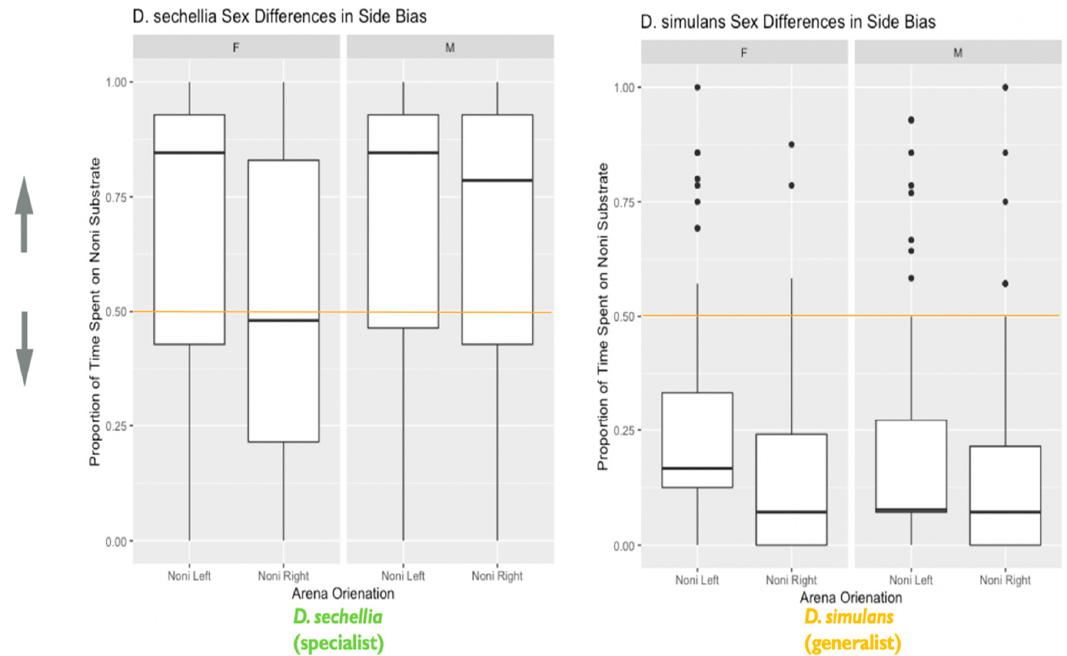
Figure 6. Species and sex di ff erences in the e ff ect of side bias on habitat choice: the plot represents species and sex di ff erences in the e ff ect of side bias on habitat choice, as described in the main text. Data are from the second experiment measuring habitat choice as a representation of decision making. The y-axis represents the proportion of time spent on the imitation noni substrate. Lower values closer to 0 indicate a habitat preference for the plain substrate, while higher values closer to 1 indicate a habitat preference for the imitation noni substrate. A value on or near 0.5 (marked by the orange line) indicates no demonstrable habitat preference for either the plain or imitation noni substrates. The x-axis is divided both by sex, as well as the arena orientation i.e., whether imitation noni substrate was on the left or right ( n = 526 flies). The box in the plot represents the inter-quartile range of scores, including the middle 50% of scores for the group, with the median score represented by the middle quartile mark (or line). The whiskers represent the score ranges outside the inter-quartile range, including the top 25% of scores for the group in the upper whisker, and the bottom 25% of scores in the lower whisker. The dots beyond the whiskers represent outlier values. Our findings indicated that species and sexes di ff ered significantly in habitat choice. Additionally, a left-side bias significantly influenced habitat choice, with females showing a stronger e ff ect of left-side bias on habitat choice than males.